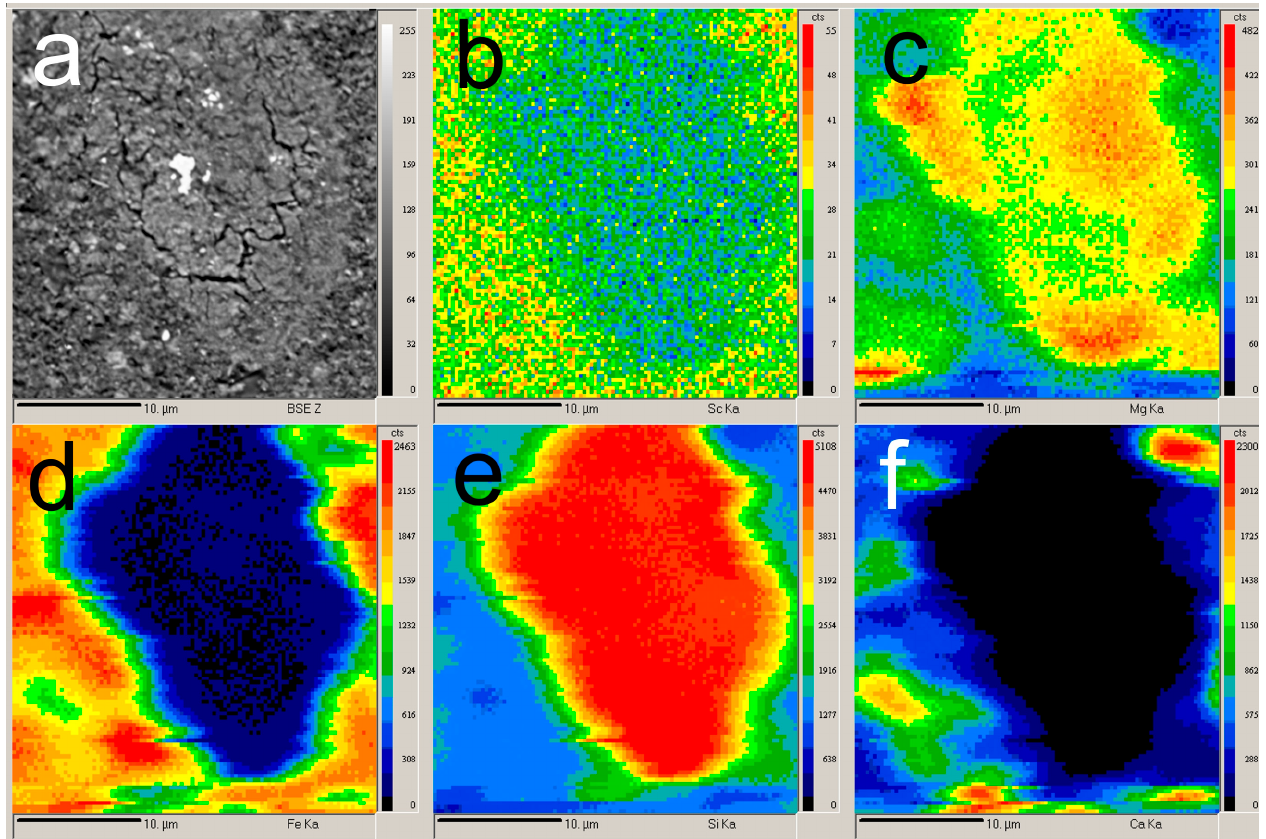
Figure 2. EPMA of the initial red mud obtained by alkali fusion-leaching of bauxite (RMF): ( a ) BSE image of the RMF surface; ( b ) mapping of the Sc distribution; ( c ) mapping of the Mg distribution; ( d ) mapping of the Fe distribution; ( e ) mapping of the Si distribution; and ( f ) mapping of the Ca distribution.